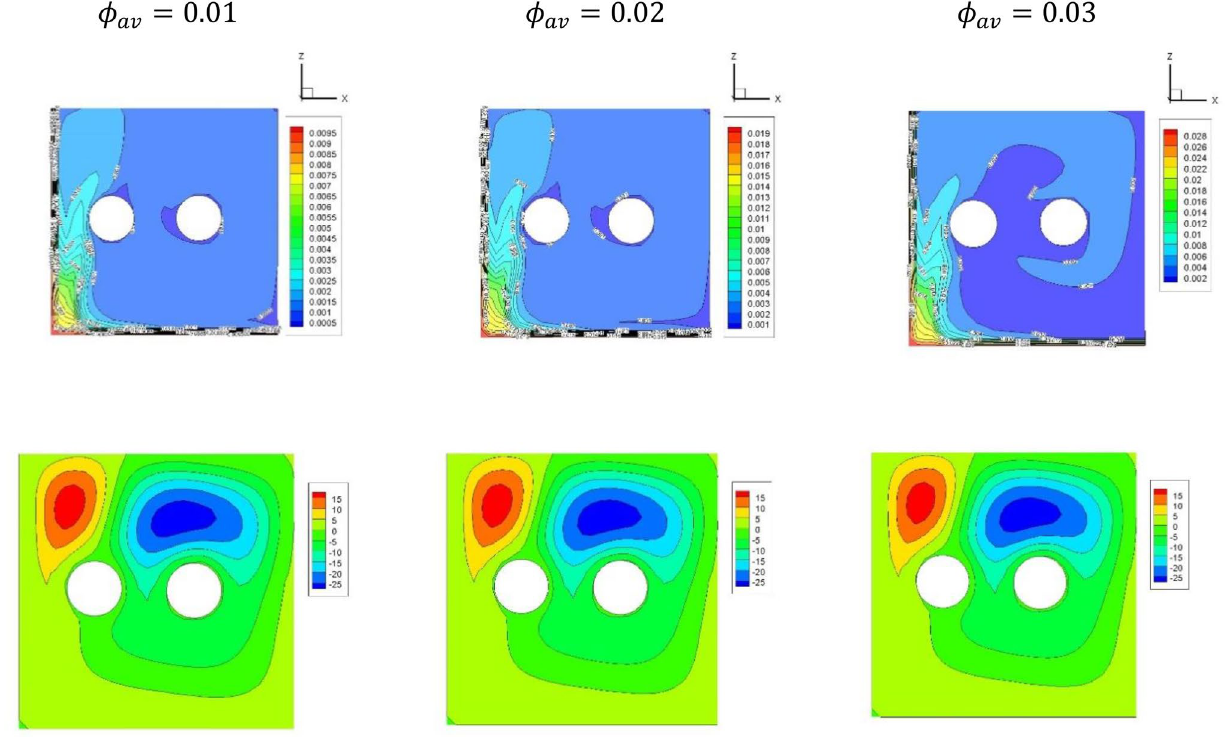
Figure 6. Plots of the nanoparticles distributions and streamlines for the variations of the φ av in case of 1.5 ) at Da (η 1 η 2 η 3 = = =